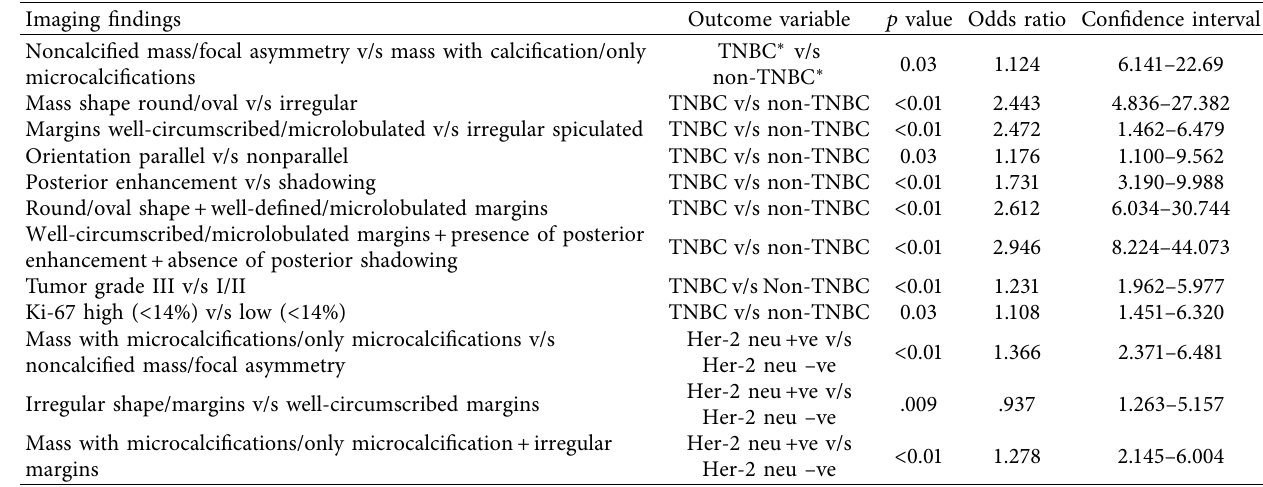
Table 5: Multivariate analysis of ultrasound and mammographic